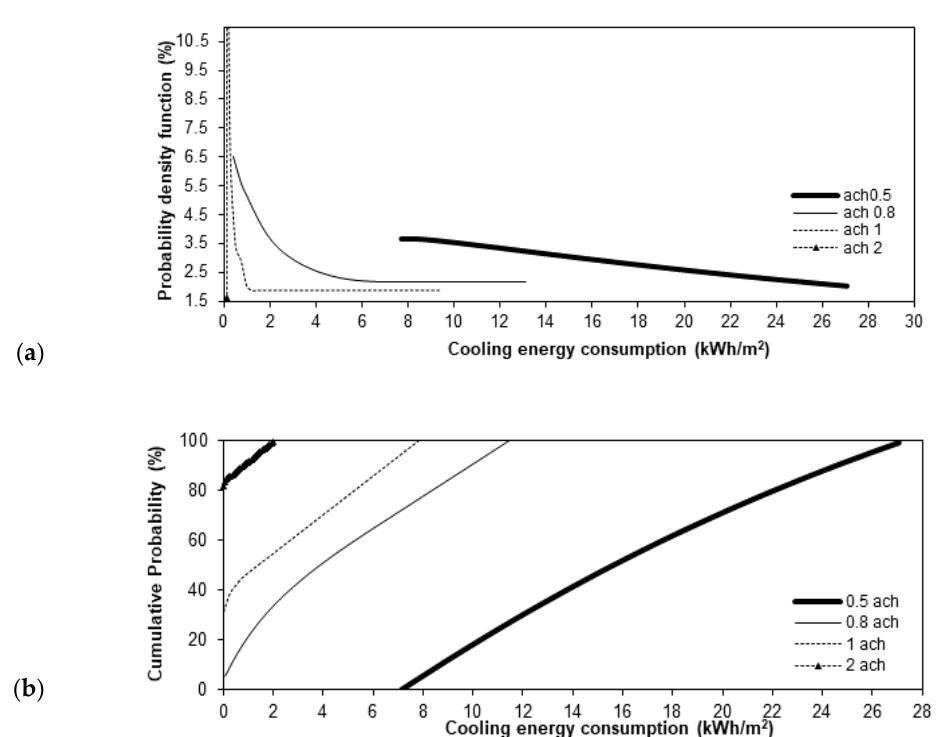
Figure 7. Probability density functions ( a ) and cumulative probability ( b ) of the cooling energy consumption for an increment of +0.5 °C in the outdoor temperature.